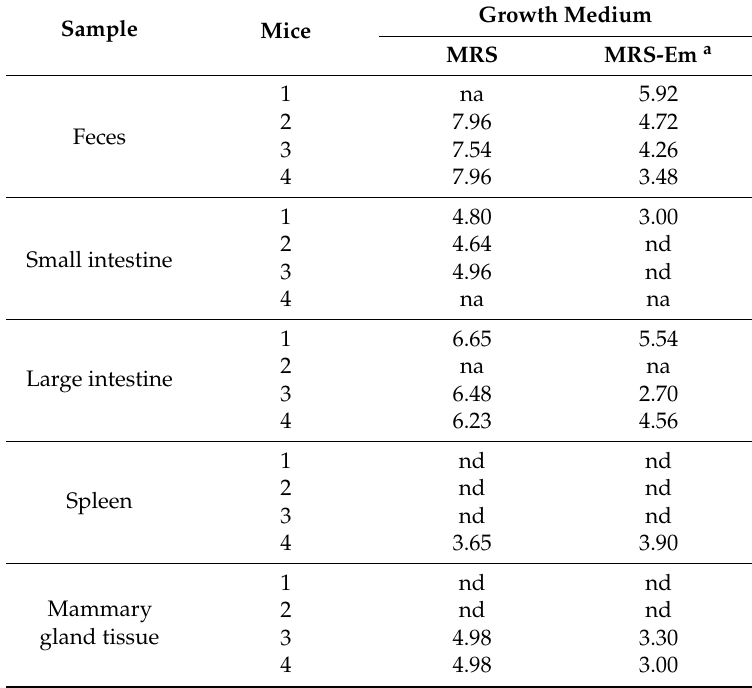
Table 2. L. salivarius PS2 counts (log 10 cfu/g) in the biological samples collected from mice (1 and 2: non-pregnant mice; 3 and 4: pregnant mice) that were fed with L. salivarius PS2 cells transformed with plasmid pMG36e:: luxAB.